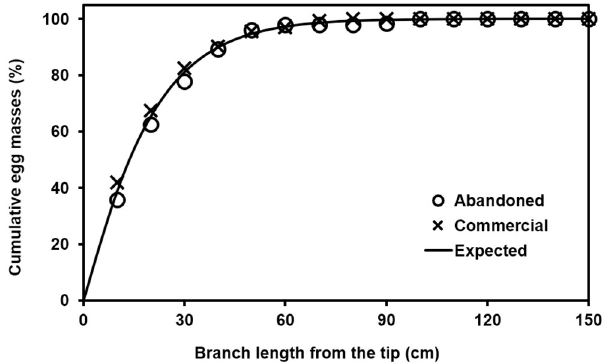
Fig 2. Cumulative egg mass proportion (%) of R . shantungensis according to distances from the tip within a branch.